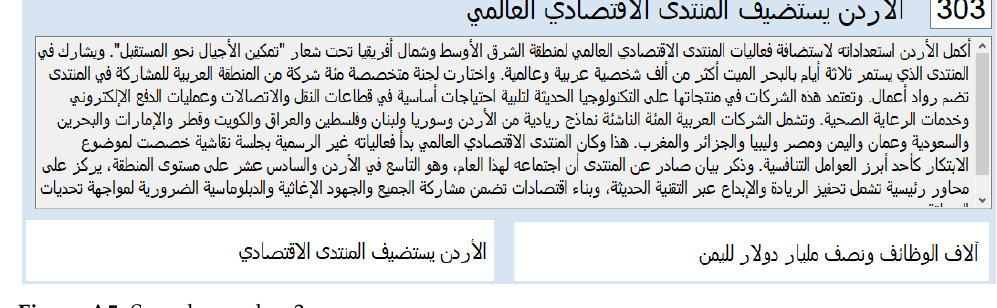
Figure A5. Sample number 3.